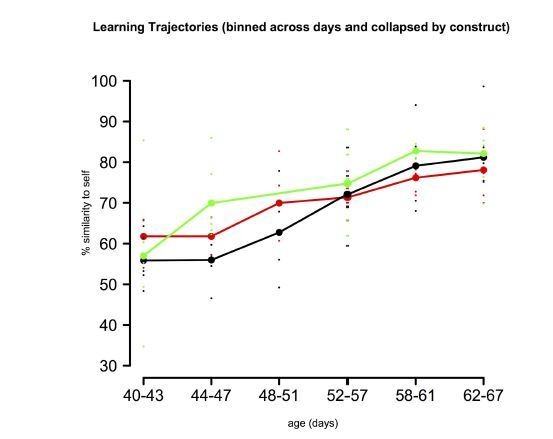
Learning trajectories demonstrate that birds’ songs change over song development.Learning trajectory is calculated by quantifying acoustic similarity between birds’ songs over the course of the experiment and their song on the day of sacrifice (~65d). Upward trajectory indicates the songs for all three virus groups change over time. In agreement with the work of Heston & White, (2015), the FoxP2.FL group’s (black) song changes over time but, as illustrated in main text Figure 3D, not to match the tutor’s song.